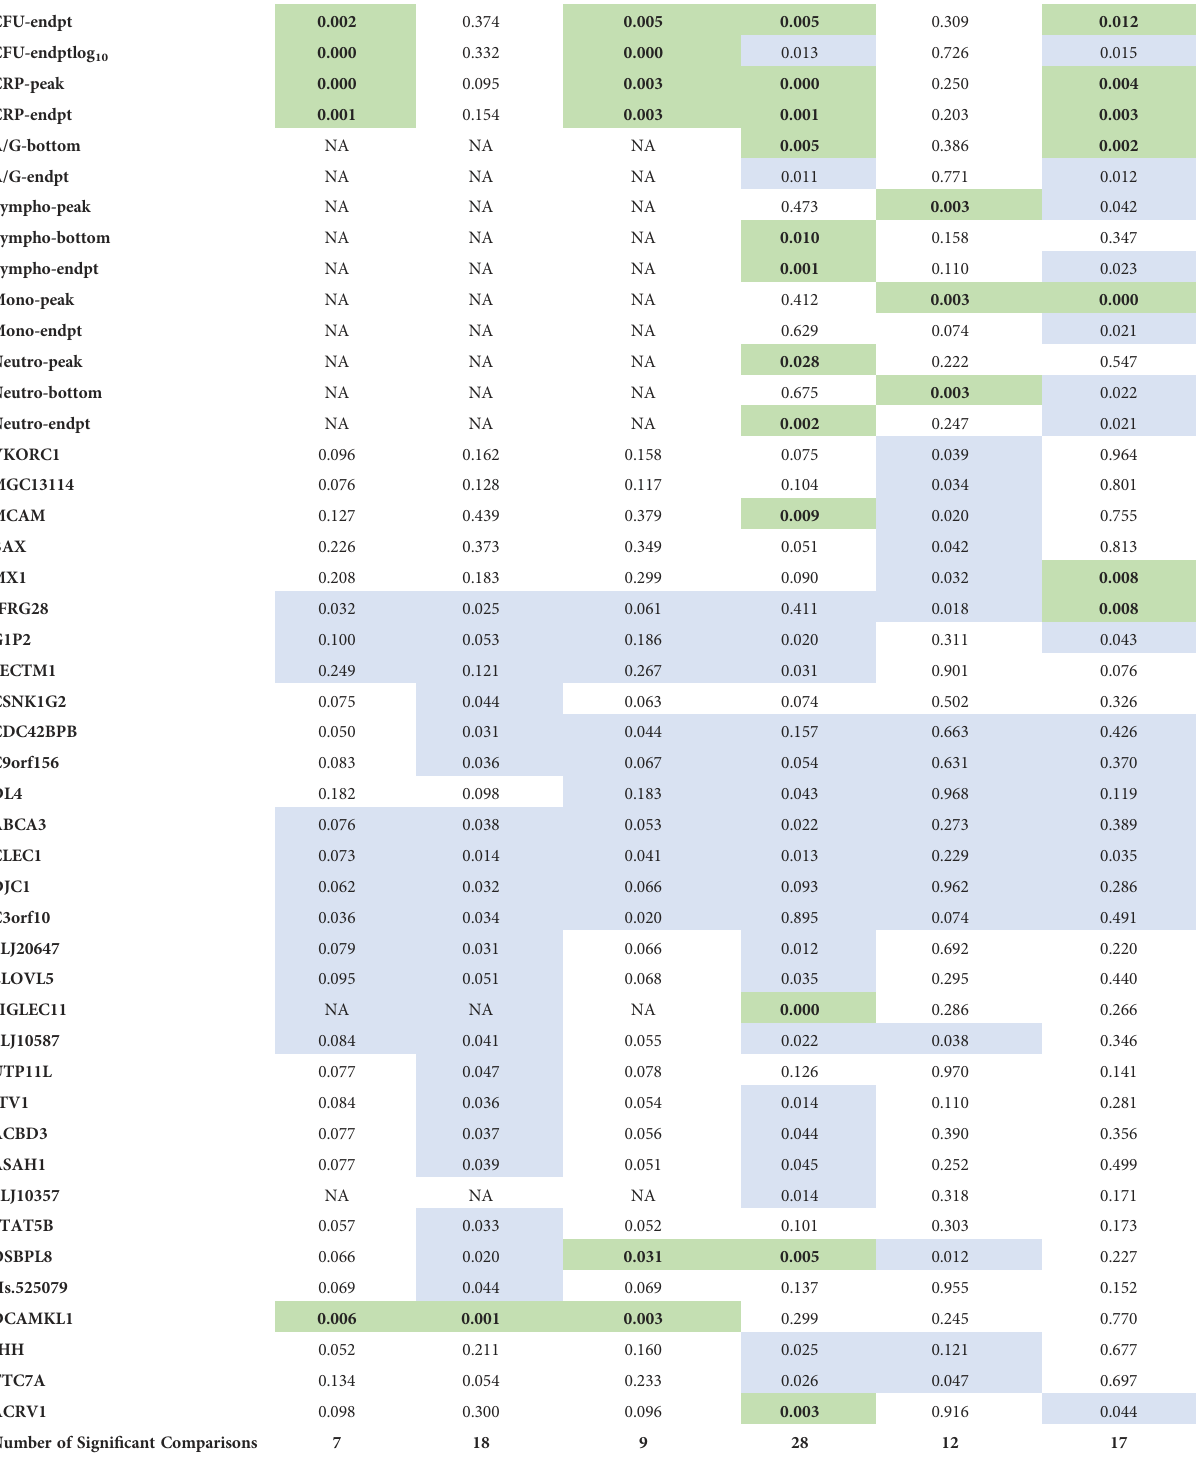
The highlighted values represent signi fi cant